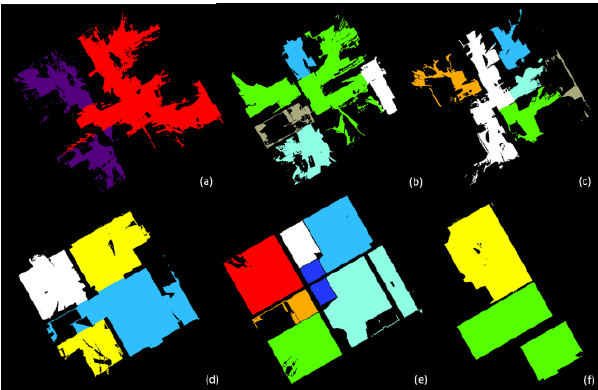
Figure 17. Distance from original point cloud to the estimated